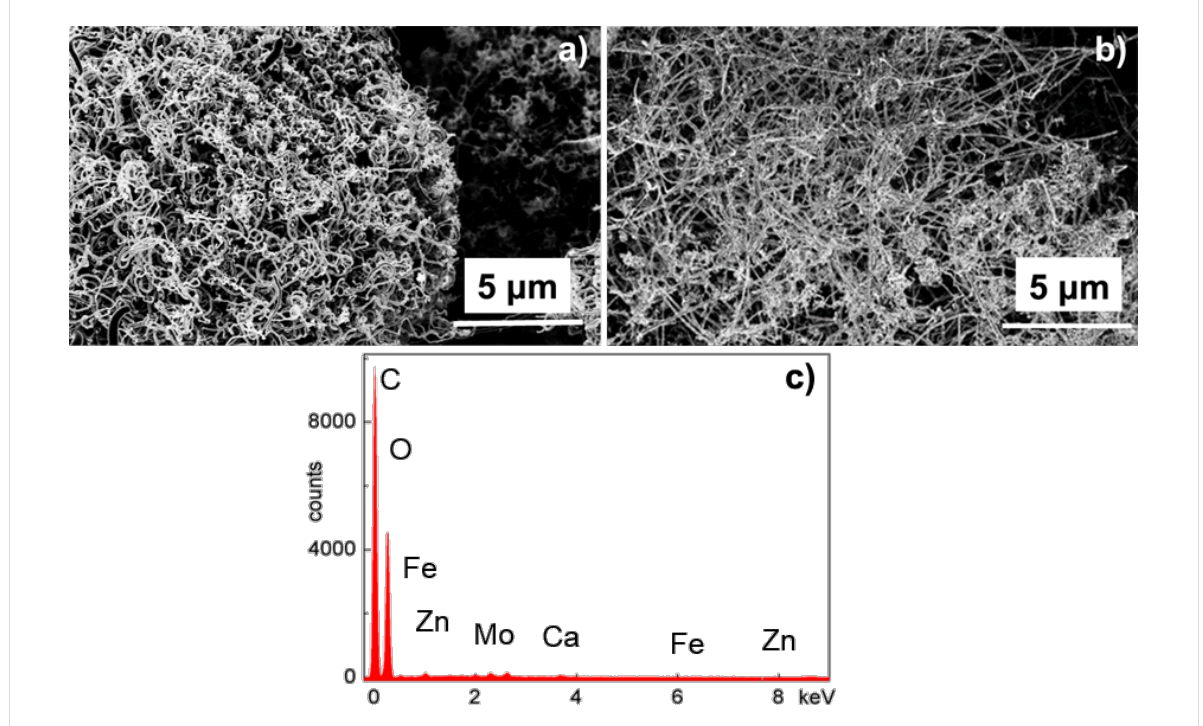
Figure 7: SEM micrographs of the CNT-sponge surface after one (a) and two (b) burning processes. Correspondent EDX spectrum collected from sample (a) showing some constituents of the adsorbed oil together with the main components of the CNT-sponge (c).